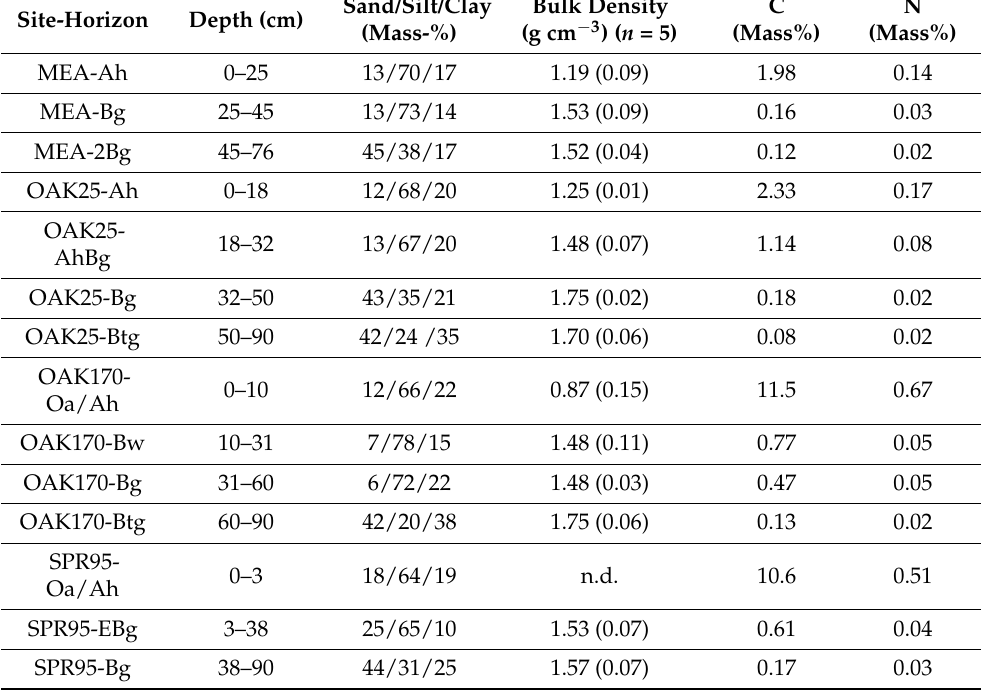
Table 1. Basic soil properties of the four sites. Analysis for texture and C and N were performed using bulk samples per horizon. Bulk density was determined by 100 cm 3 rings in 5 repetitions. Here, arithmetic mean and standard deviation (in brackets) are presented. Stone content was negligible in all analyzed horizons. Description of the horizons are according to WRB. n.d., not determined.